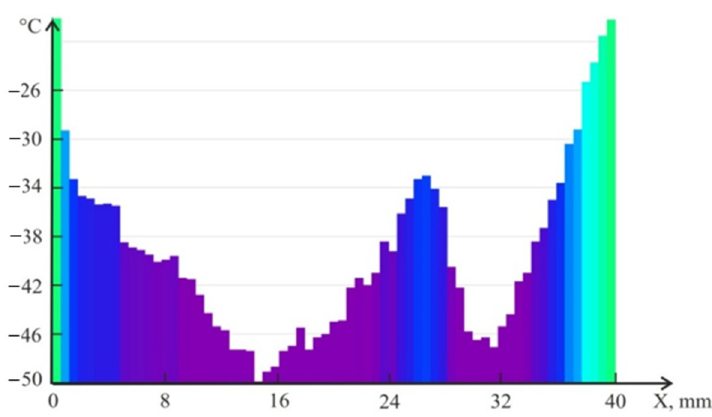
Figure 9. Temperature profile of the powder surface along the 0X line shown in Figure 8a,b.